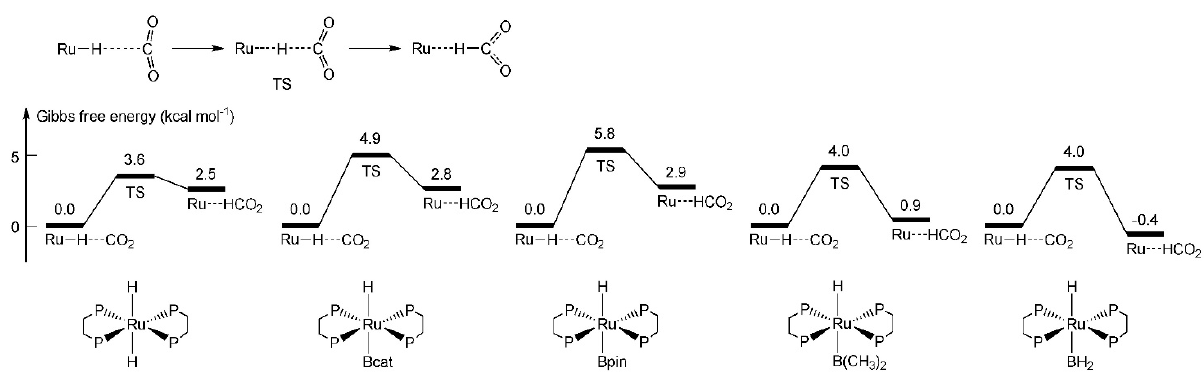
Figure 3. Free energy profile for hydride addition to CO 2 on trans-[Ru(dmpe) 2 HX] complexes (X may be hydride or B ligand). The substituent on phosphorus is omitted for clarity.